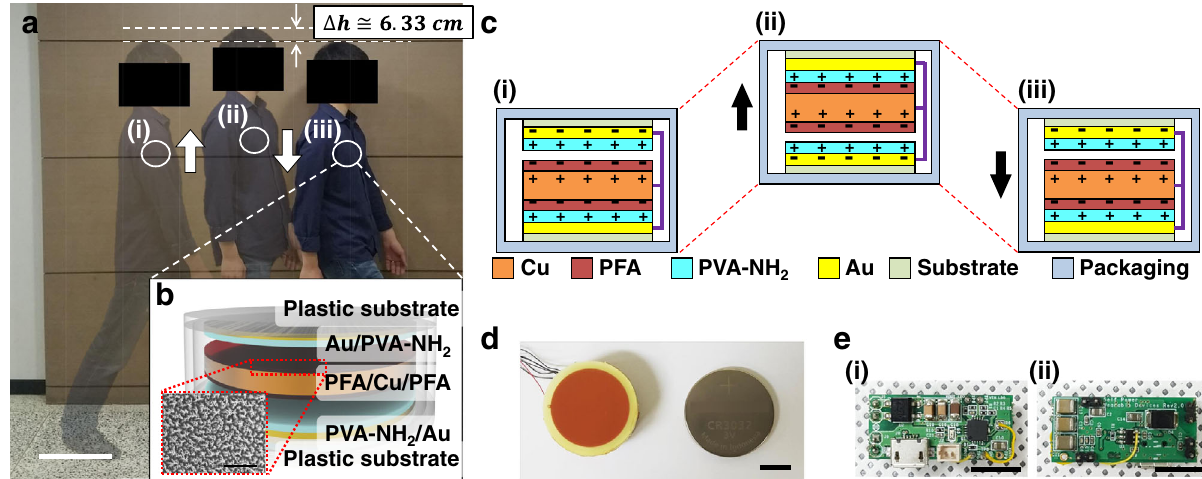
Fig. 1 Overview of the in vivo triboelectric nanogenerator driven by inertia. a Photograph of a walker showing a vertical displacement of ~6 cm. scale bar, 30 cm. b Schematic image of the I-TENG, and surface SEM image of the surface-modi fi ed PFA layer. scale bar, 5 μ m. c The working mechanism of the I- TENG with the freestanding unit. d Photograph of the stacked I-TENG and a commercial coin battery. scale bar, 1 cm. e Photographs of the (i) front and (ii) back of the power management system. scale bar, 1